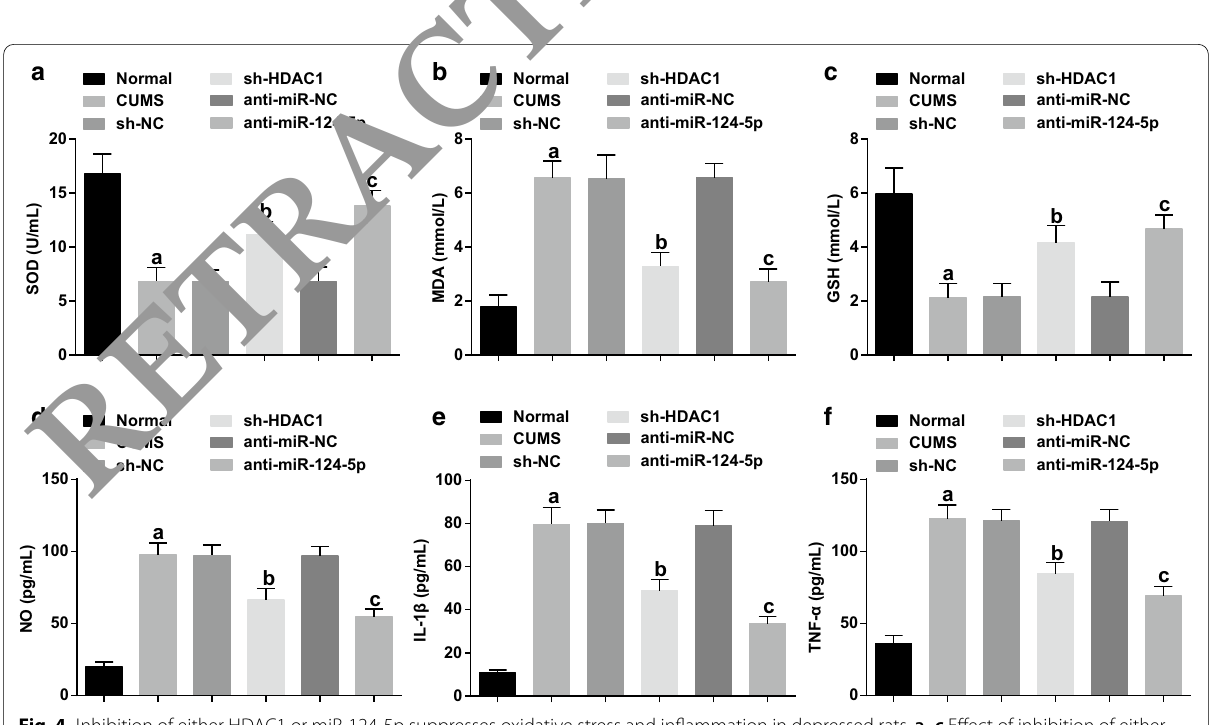
Fig. 4 Inhibition of either HDAC1 or miR-124-5p suppresses oxidative stress and inflammation in depressed rats. a – c Effect of inhibition of either HDAC1 or miR-124-5p on SOD, MDA and GSH concentration in serum of depressed rats; d – f Effect of inhibition of either HDAC1 or miR-124-5p on IL-1β, TNF-α, and NO concentration in serum of depressed rats; n 10; a P < 0.05 compared with the normal group; b P < 0.05 compared with = the sh-NC group; c P < 0.05 compared with the anti-miR-NC group. Comparisons among multiple groups were evaluated by one-way ANOVA, and pairwise comparisons by Tukey’s post hoc